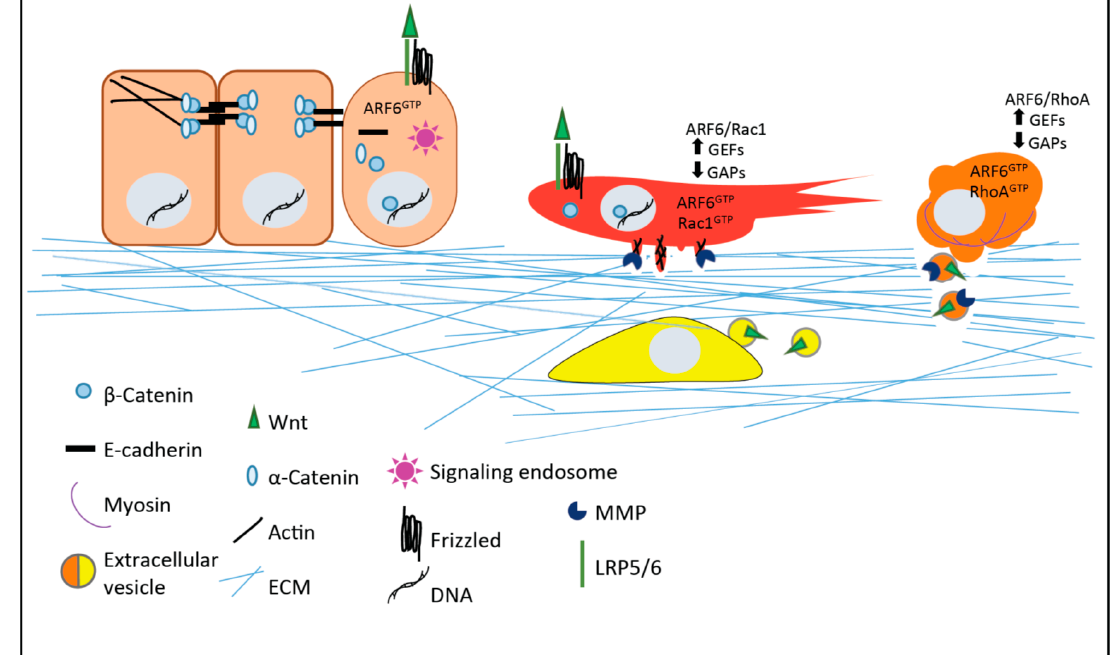
Figure 2. Wnt signaling impacts tumor progression and invasion. Wnt ‐ regulated cellular changes include facilitating the dissociation and internalization of cadherin ‐ based adhesions (cuboidal cells on the left) and the formation of invadopodia in migratory tumor cells (red). Wnt may also be included as cargo in extracellular vesicles released from amoeboid tumor cells (orange) as well as other cells such as fibroblasts in the tumor microenvironment (yellow). Small GTP ‐ binding proteins of the ARF and Rho families, regulated by various GTPase activating proteins (GAPs) and guanine nucleotide exchange factors (GEFs), mediate many of these processes.